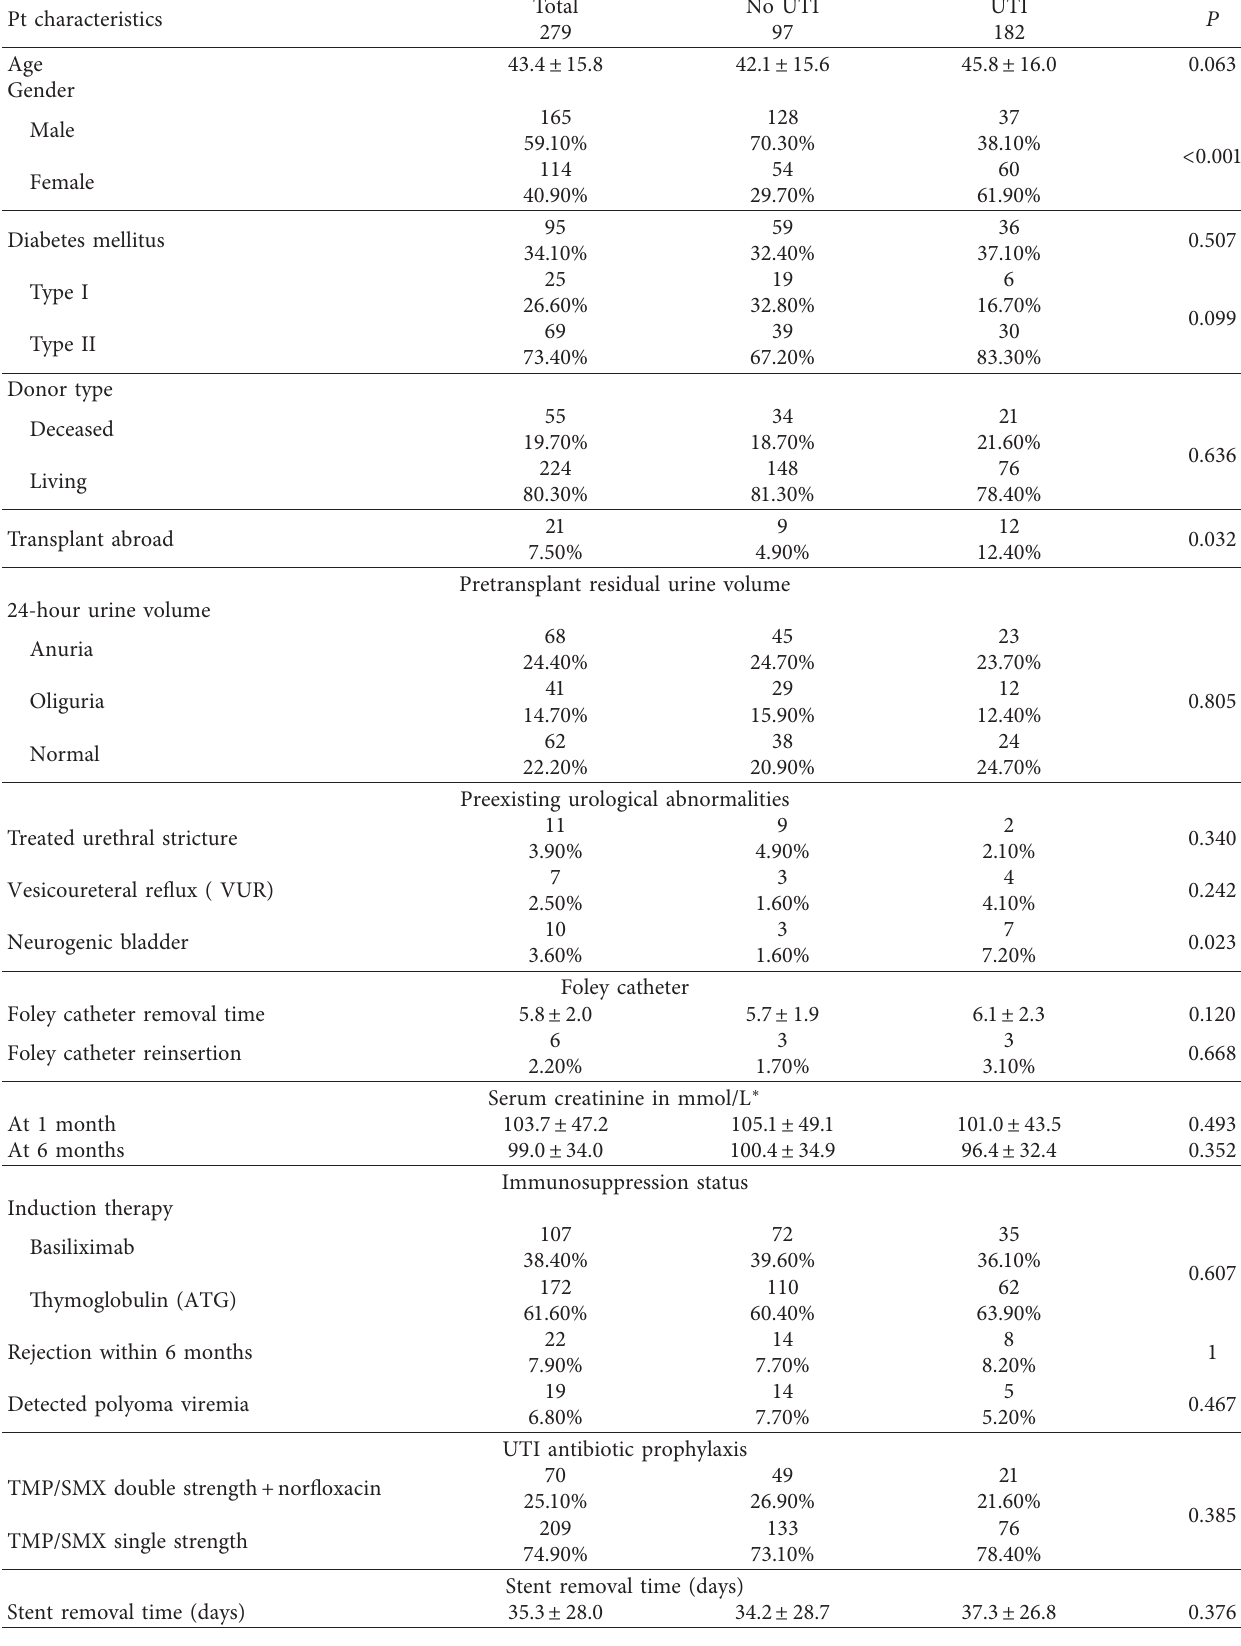
Table 1: Patients’